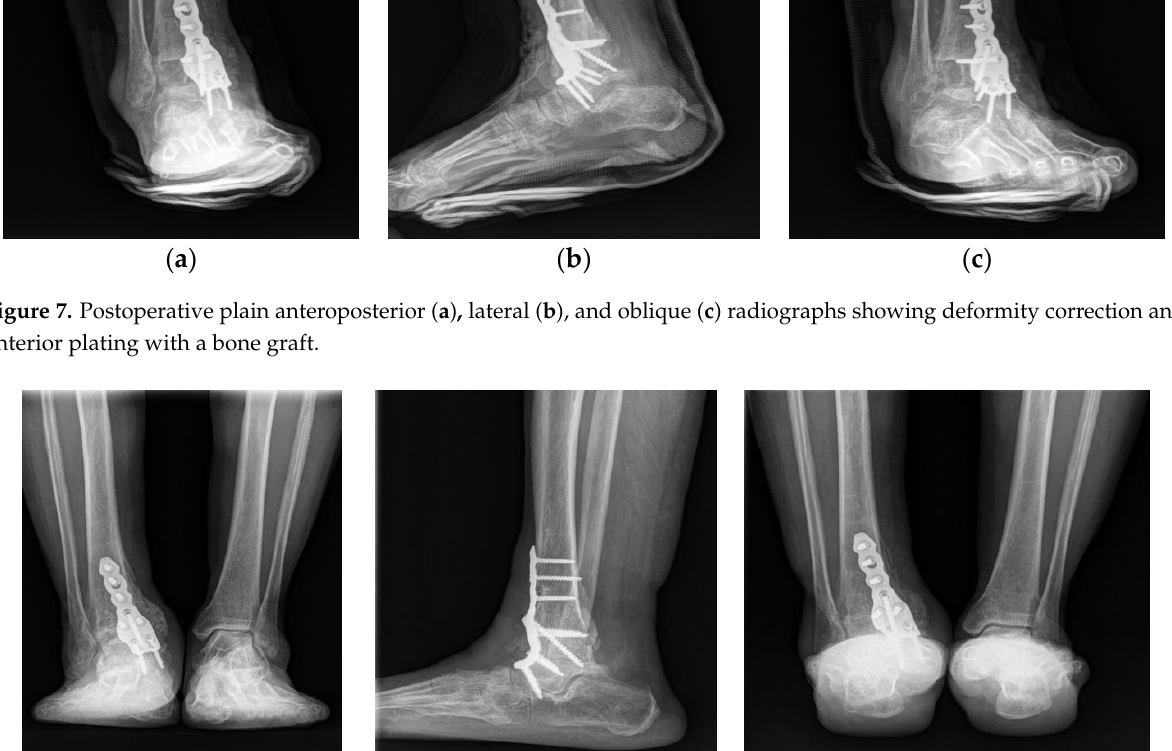
Figure 7. Postoperative plain anteroposterior ( a ) , lateral ( b ), and oblique ( c ) radiographs showing deformity correction and anterior plating with a bone graft.